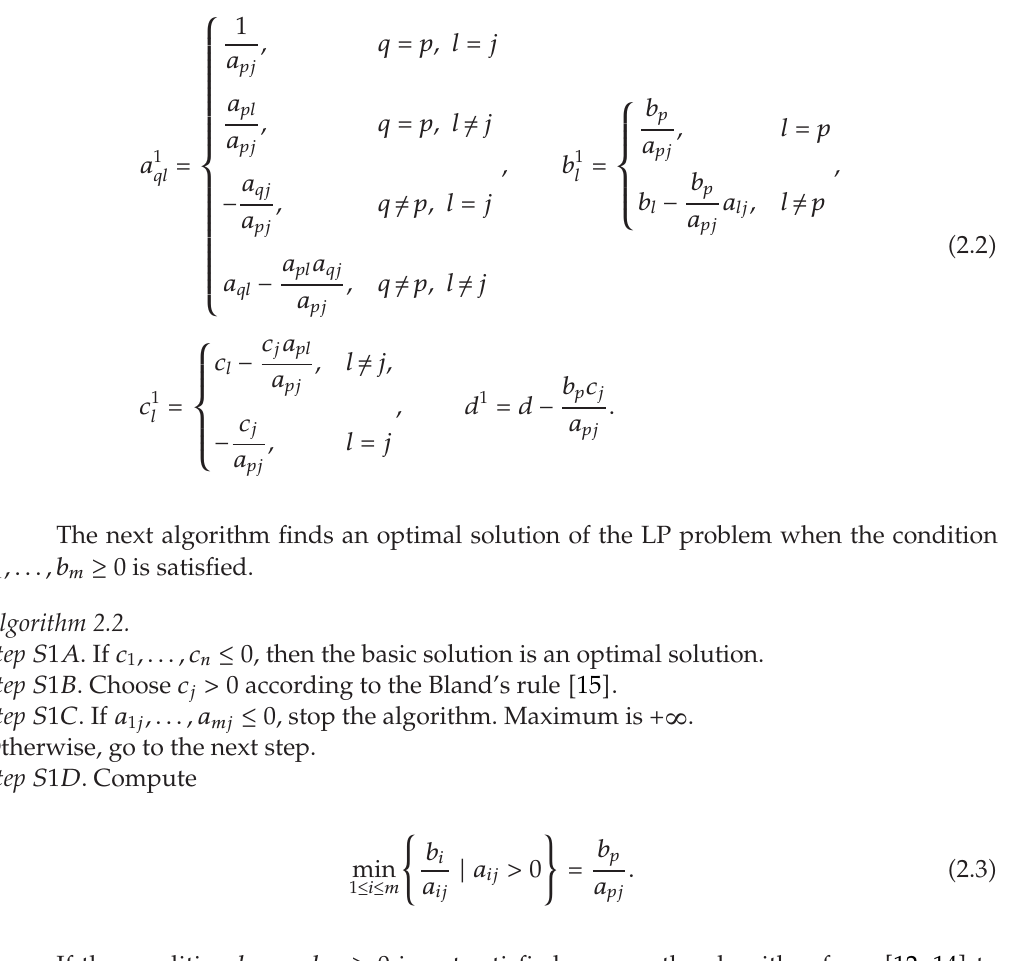
Algorithm 2.1 (cid:6) consider interchange a basic variable x B,p and nonbasic variable x N,j (cid:7)